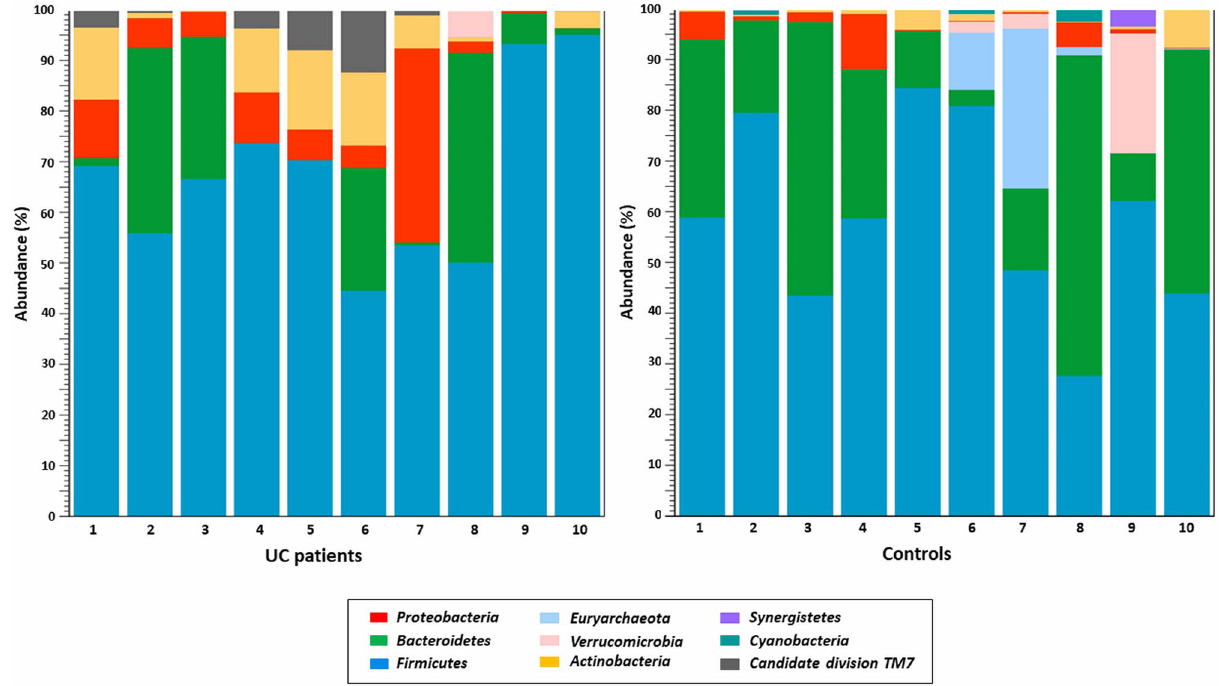
Figure 2. Individual profiles of gut microbial composition at the phylum level in the UC patient and control